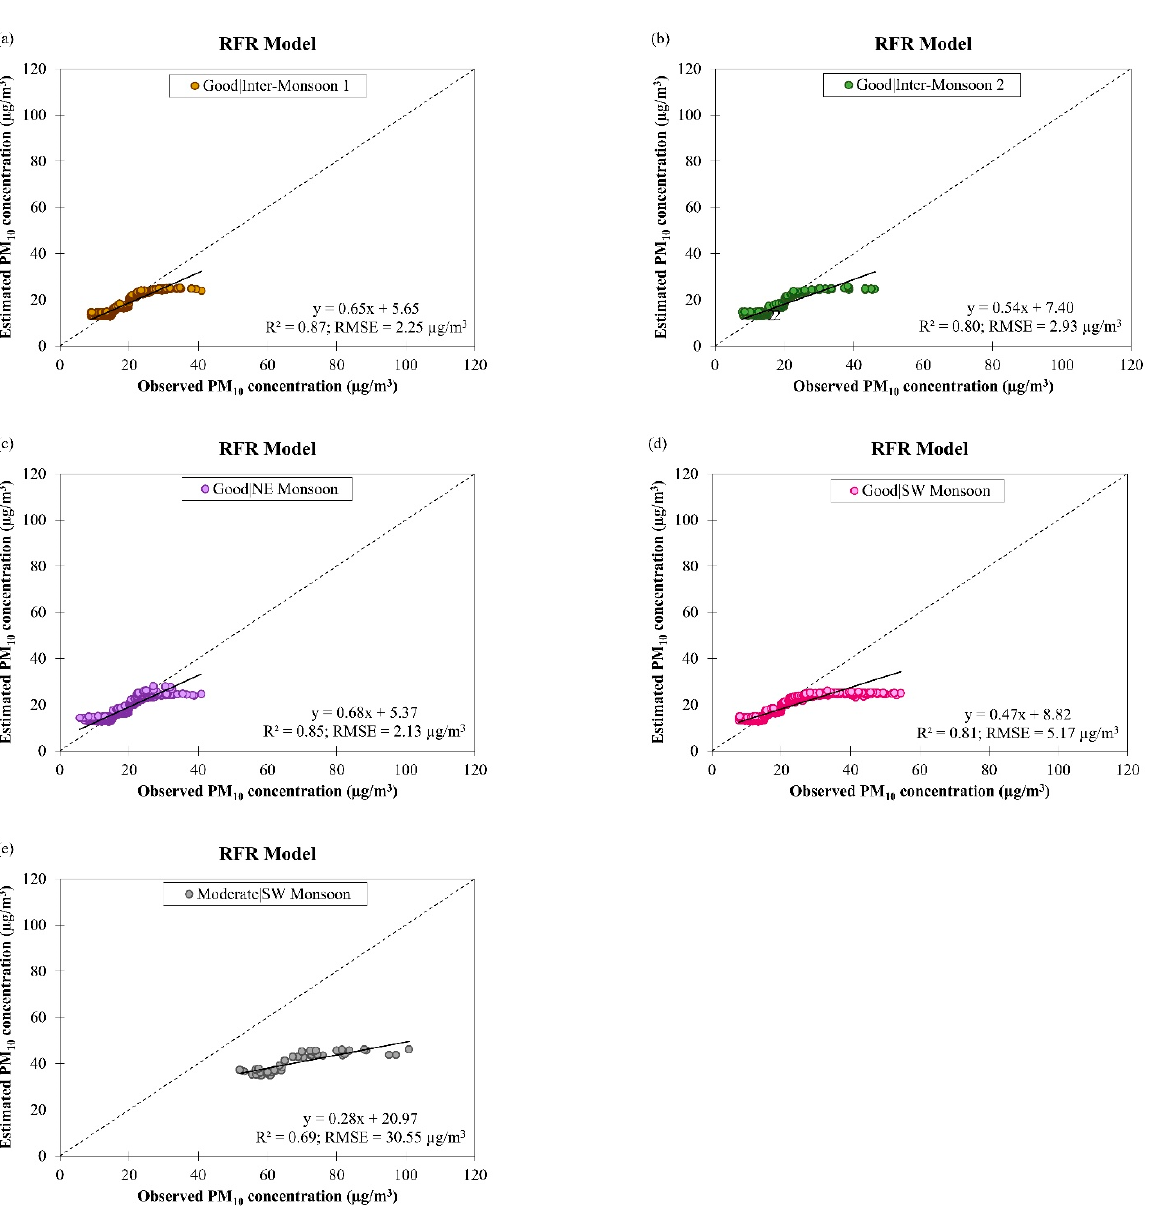
Figure 18. Scatter plots of estimated daily PM 10 concentration against observed daily PM 10 concen- tration by RFR model for ( a – d ) good air quality condition during different monsoon seasons and ( e ) moderate air quality condition during SW monsoon in Brunei Darussalam from January 2009 to December